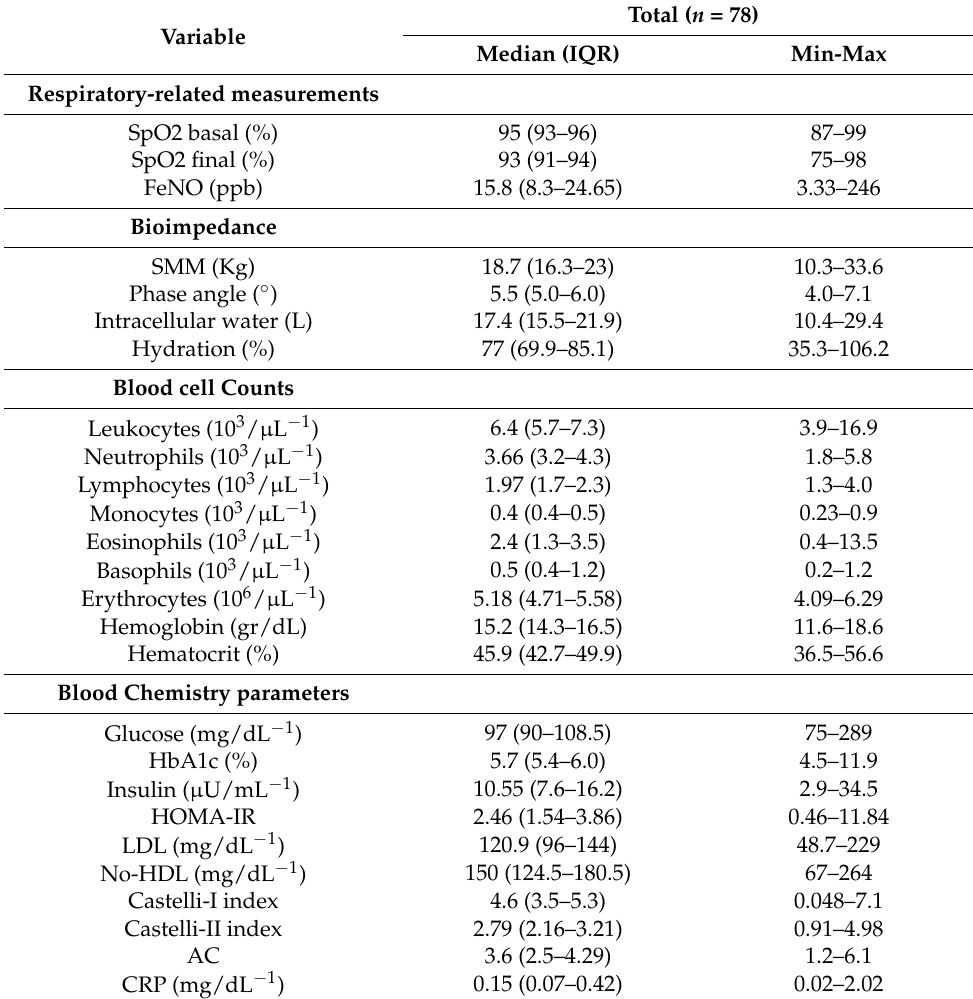
Table 2. Descriptive respiratory-related measurements, bioimpedance, hematic biometry, and blood chemistry of patients recruited by National Institutes of Health, Mexico